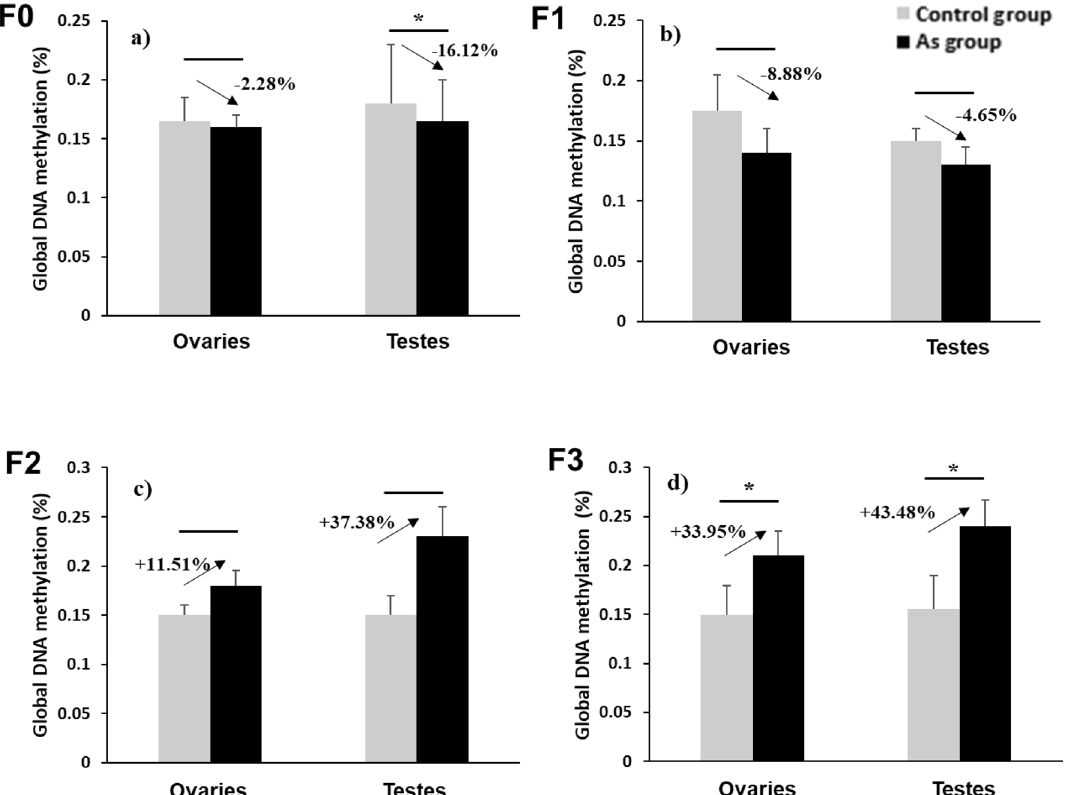
Figure 4. Global DNA methylation and %Δ5-mC (arrows); ( a – d ) show intra-gender comparisons between control lineage (n = 24; grey bars) and arsenic lineage (n = 40; black bars) in F0, F1, F2 and F3 respectively. Error bars: standard deviation. (*) p <